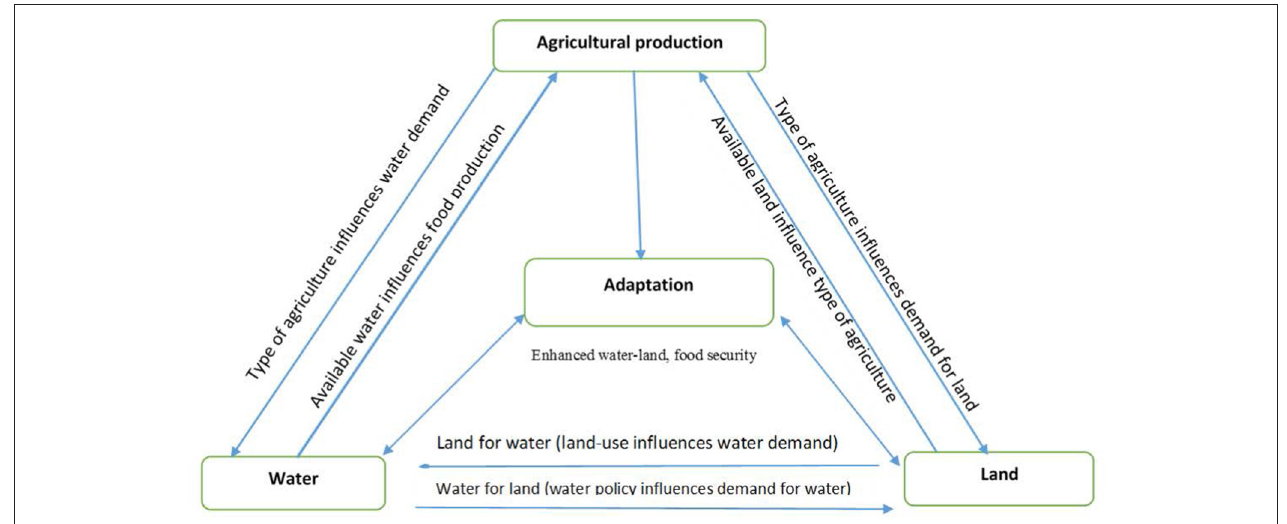
FIGURE 2 | The interface between water, land, and food